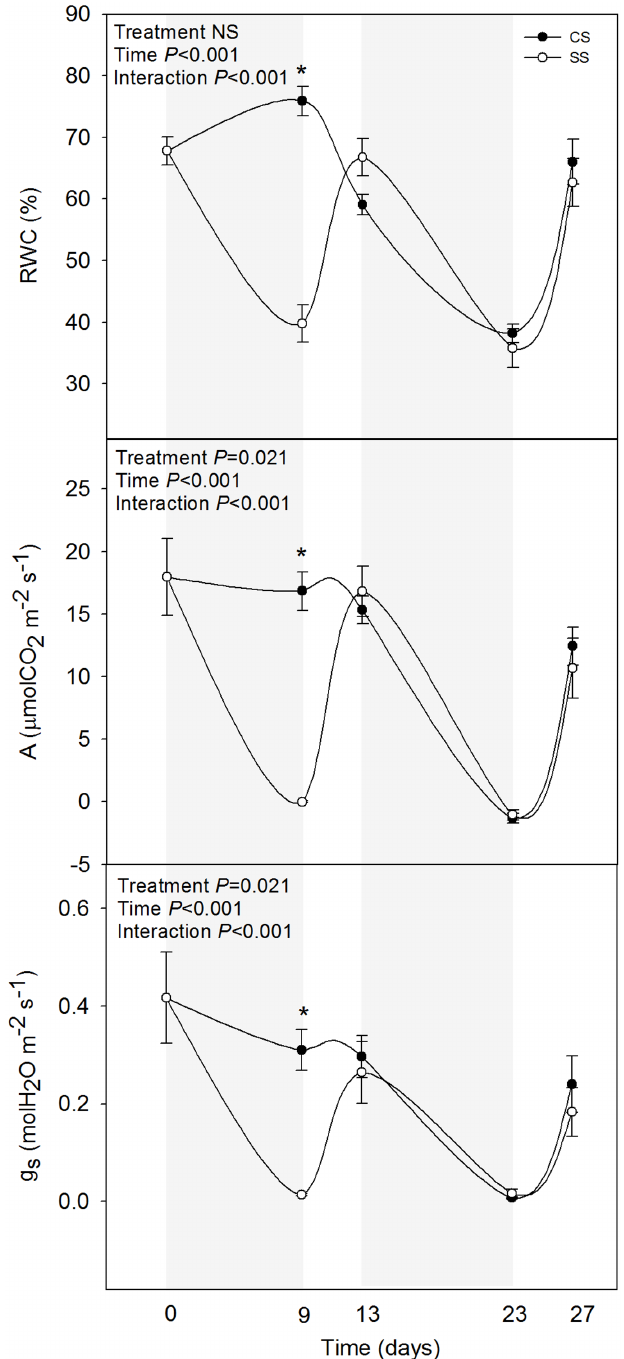
Fig 1. Relative water content (RWC), CO 2 assimilation (A) and stomatal conductance (g s ) in leaves of A . cordifolia . Data represent the mean ± SE of n = 7 individuals. Significant differences between groups were tested by two-way analysis of variance (ANOVA) and Duncan posthoc